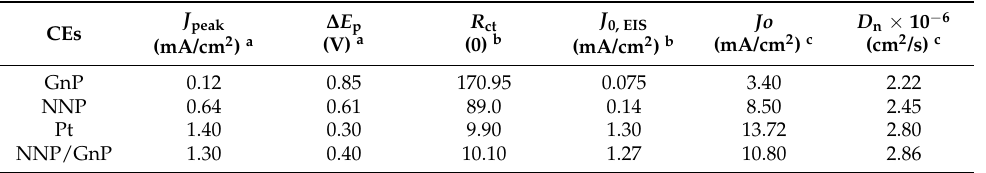
Table 1. Electrochemical parameters of the various